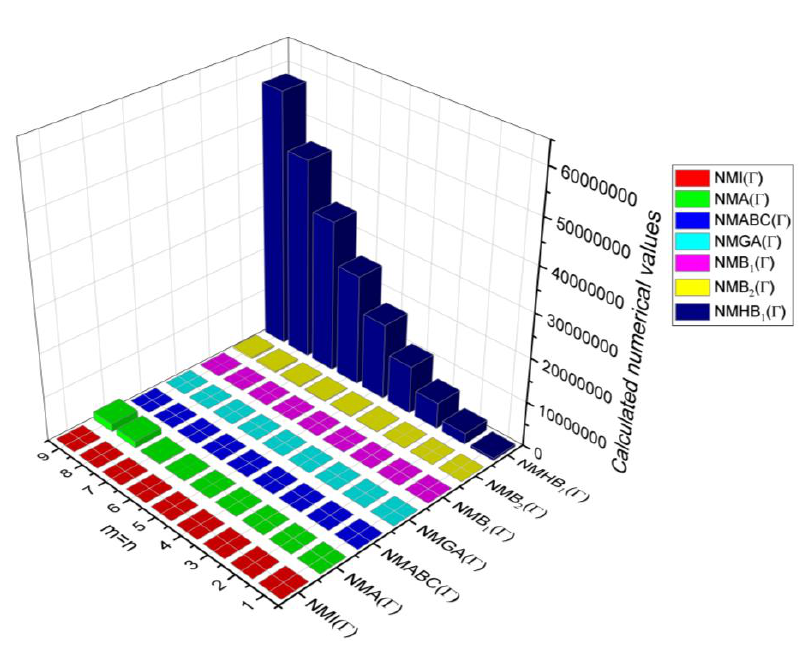
Figure 4. 3D Plots for Table 4. Table 3. Comparison Table for Theorem 2.